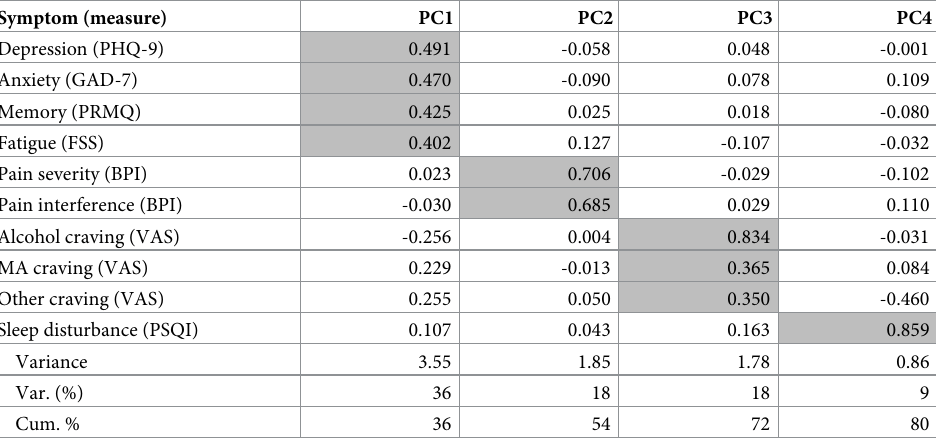
Table 2. Pattern structure (loadings) of addiction-related symptoms identified through PCA a .